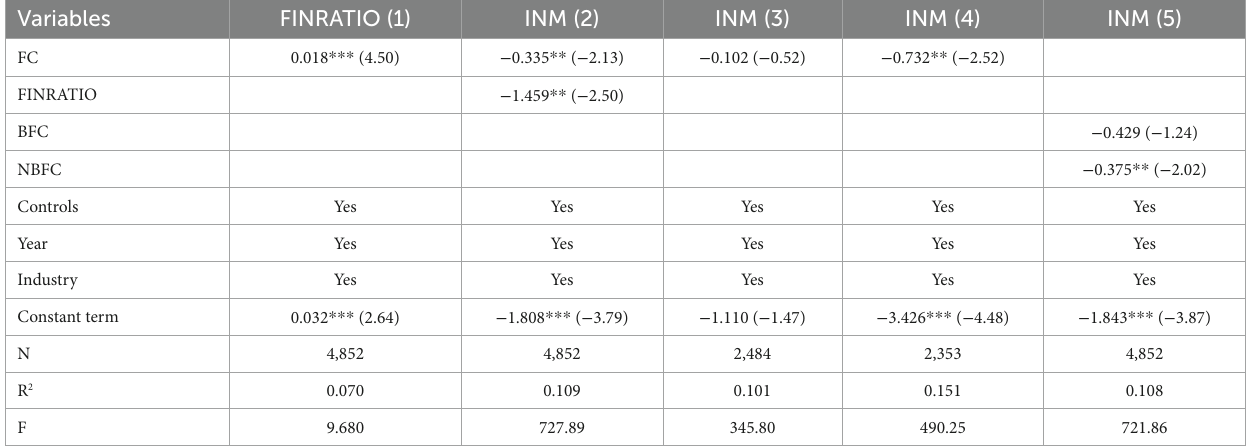
TABLE 6 Further